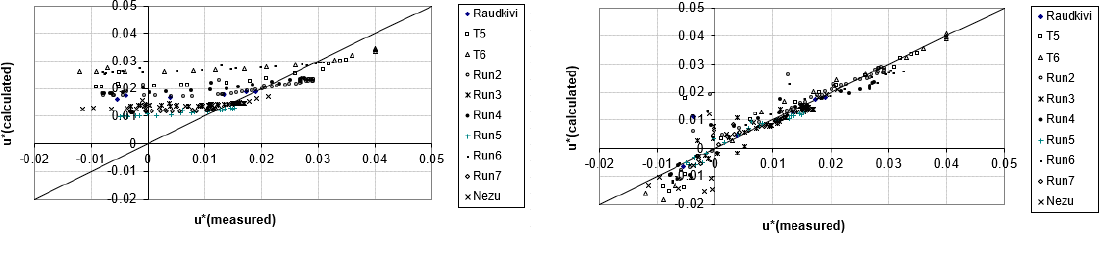
Figure 8. Comparison between the data and the predicted shear